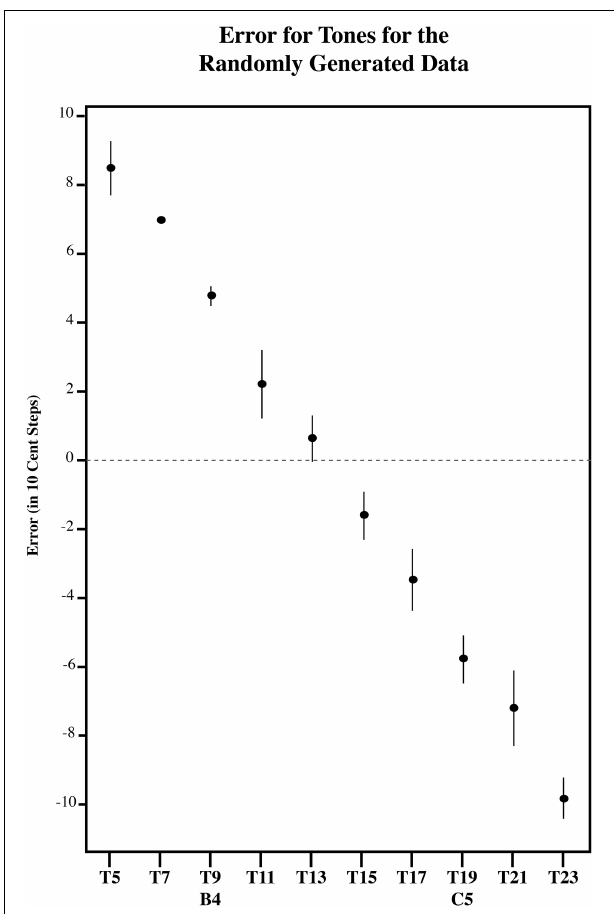
FIGURE 11 | The error in 10-cent steps for each tone in for the RGD. All tones are significantly different from one another using a Sidak adjustment (alpha 0.05) except tone 1 with 2; 3 with 4; 4 with 3, 5, 6, and 7; 5 with 6, and 7; 6 with 7 and 8; 7 with 8 and 9; 8 with 9 and 10; and 9 with 10. Note that the RGD bisects the presented distribution at its midpoint, such that lower tones in the series are overestimated and higher tones in the series are underestimated. However, note that the RGD ( Figure 11 ) has a steeper error pattern than AP ( Figure 8 ), MN ( Figure 10 ), and ME ( Figure 9 ). Error bars represent ± 1